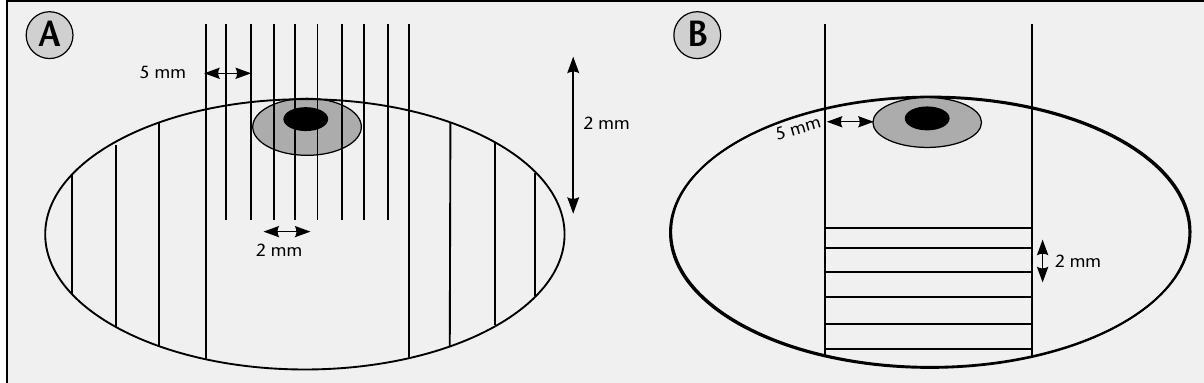
Figura 1 – Diagrama dos cortes macroscópicos da peça cirúrgica. (a) Cortes perpendiculares; (b) cortes